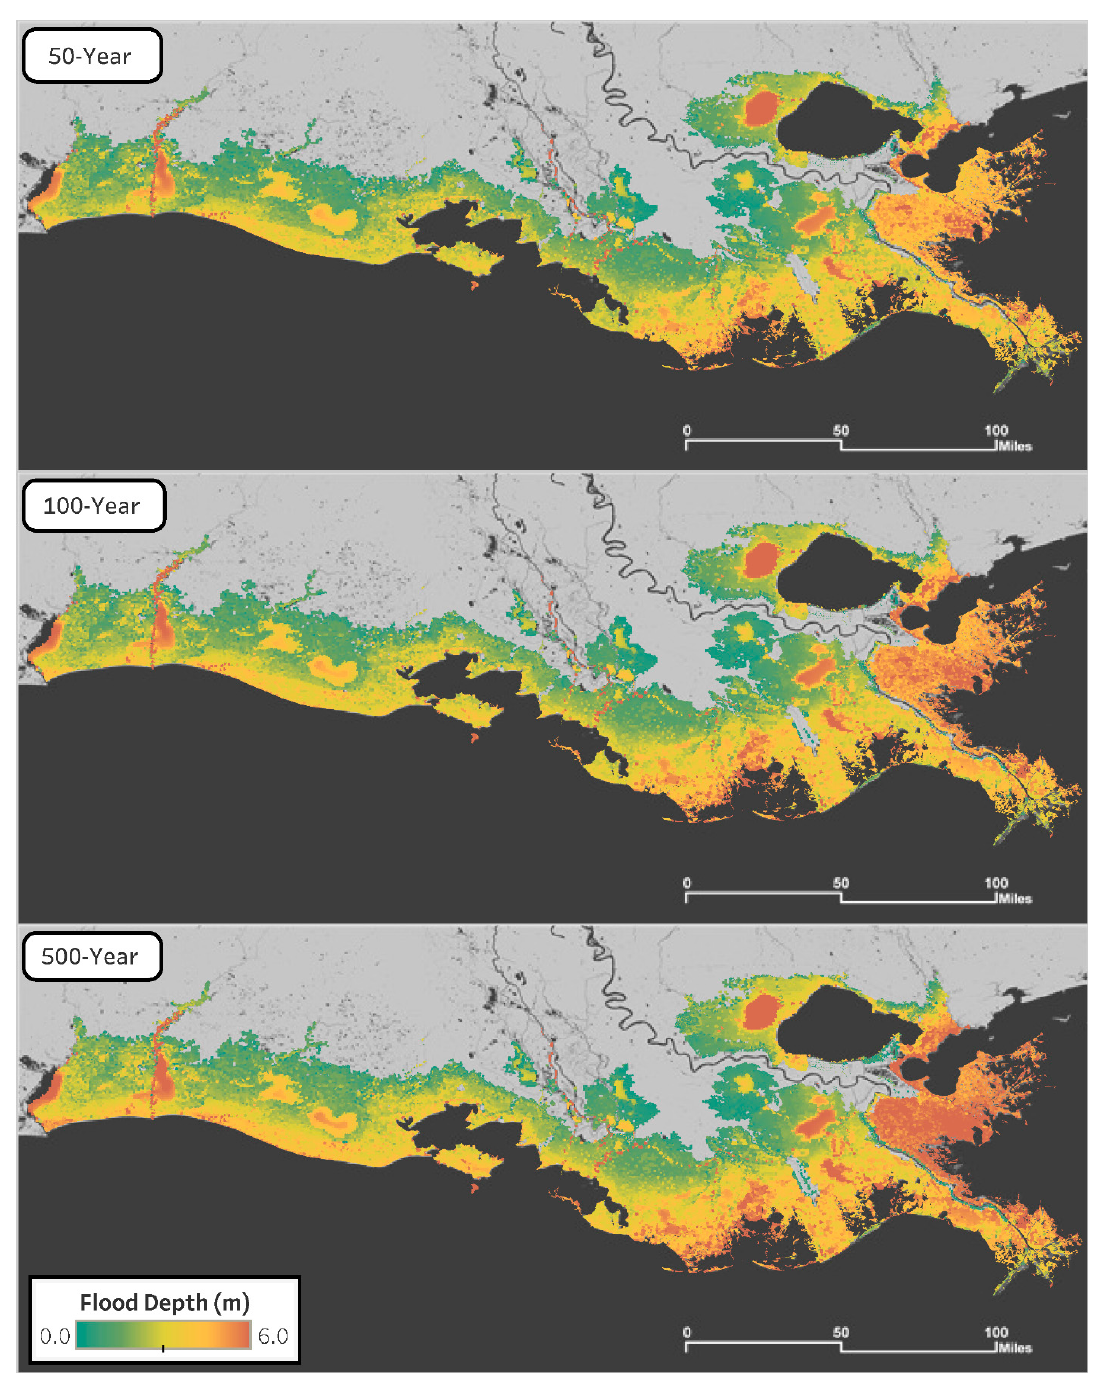
Figure 2. Reference best-estimate flood depth exceedances (input data 1950–2016).